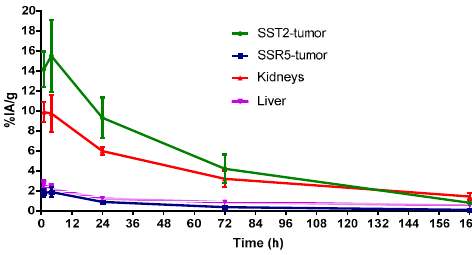
Figure 4. The area under the time–activity curve (AUC) in the SST2- and SST5-tumors, in the kidneys and the liver. These pharmacokinetic data were generated from serial independent biodistribution experiments performed 1, 4, 24, 72 and 168 h post injection.